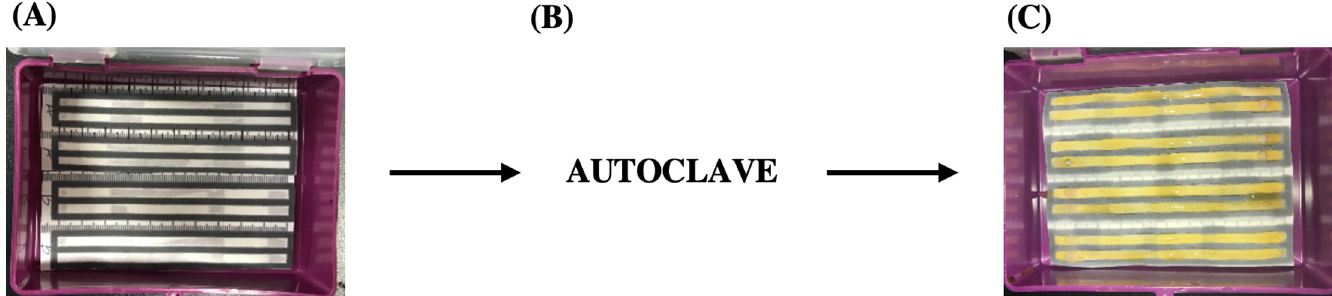
Fig 2. μ PAD device construction. The photographs show the preparation of the complete μ PAD device. (A) We taped the paper prepared via the methodology presented in Fig 1 to an interior face of an empty, clean pipet box. (B) We autoclaved the closed device and hereafter handled it with sterile technique. (C) We inoculated each channel with agar growth media and cells. After this, we closed the box, inverted the box, and added 50 mL water to the interior region of the bottom portion of the box as a humidity chamber.